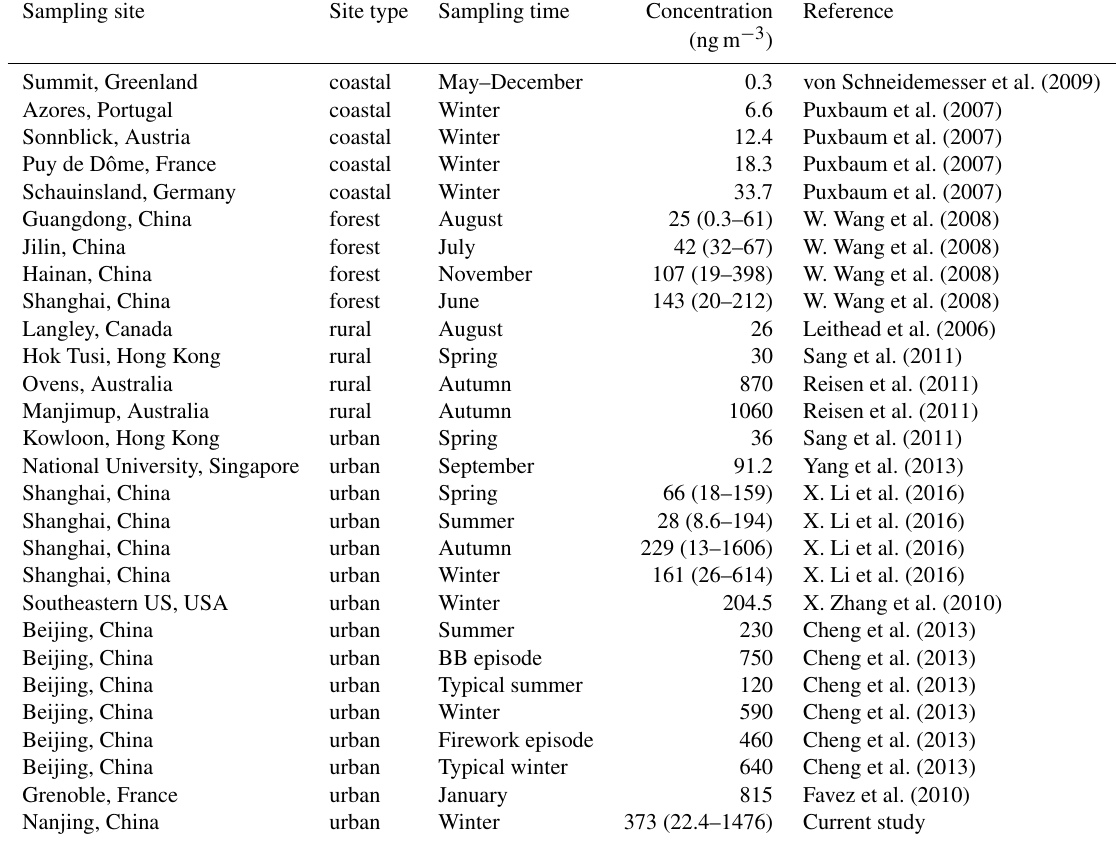
Table 2. Comparison of levoglucosan concentration level in PM 2 . 5 during this study with those reported in the literature. Sampling